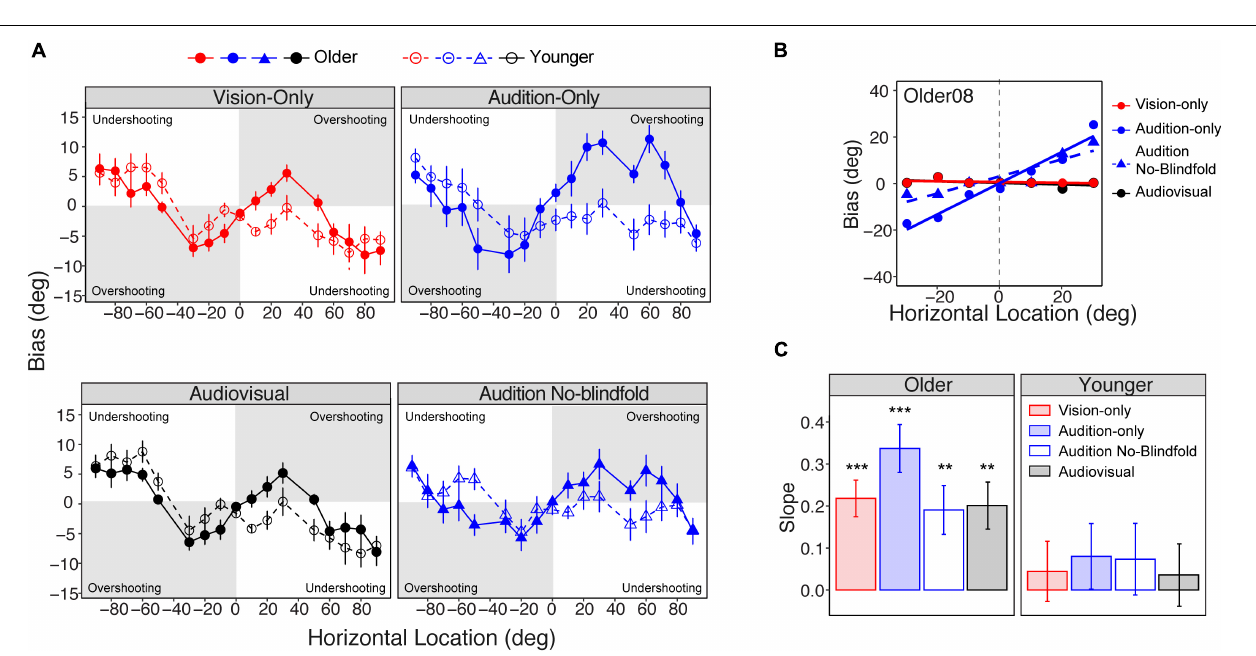
FIGURE 4 | Overall absolute error. The mean absolute error across all seventeen locations in the four conditions for the older group (left panel) , younger group (middle panel) , and both groups combined (right panel) . The error bars represent standard errors. Statistical asterisks represent significant difference between testing conditions. *** p < 0.001; ** p < 0.05.